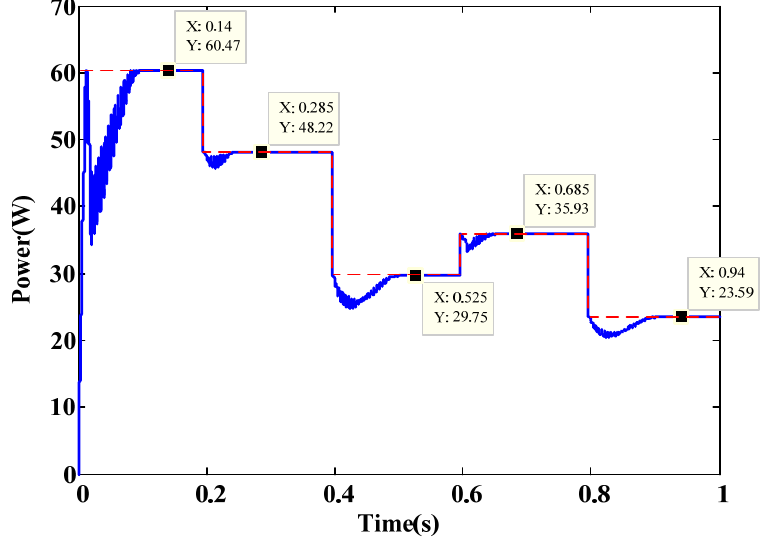
Figure 11. Simulation results for Algorithm